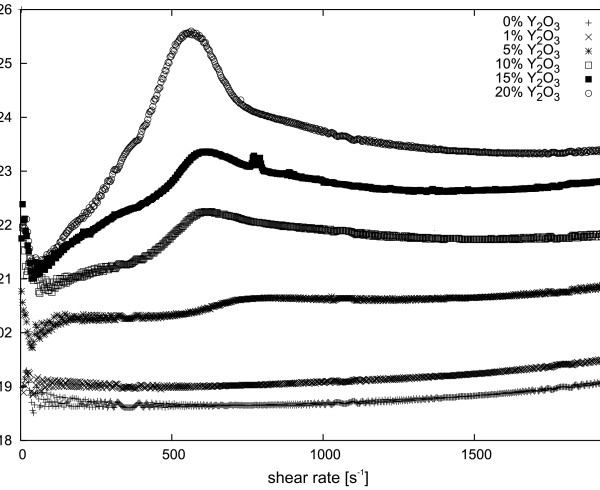
Dynamic viscosity of various weight concentrations of Y2O3nanopowder suspensions in ethyl alcohol at 5°C.